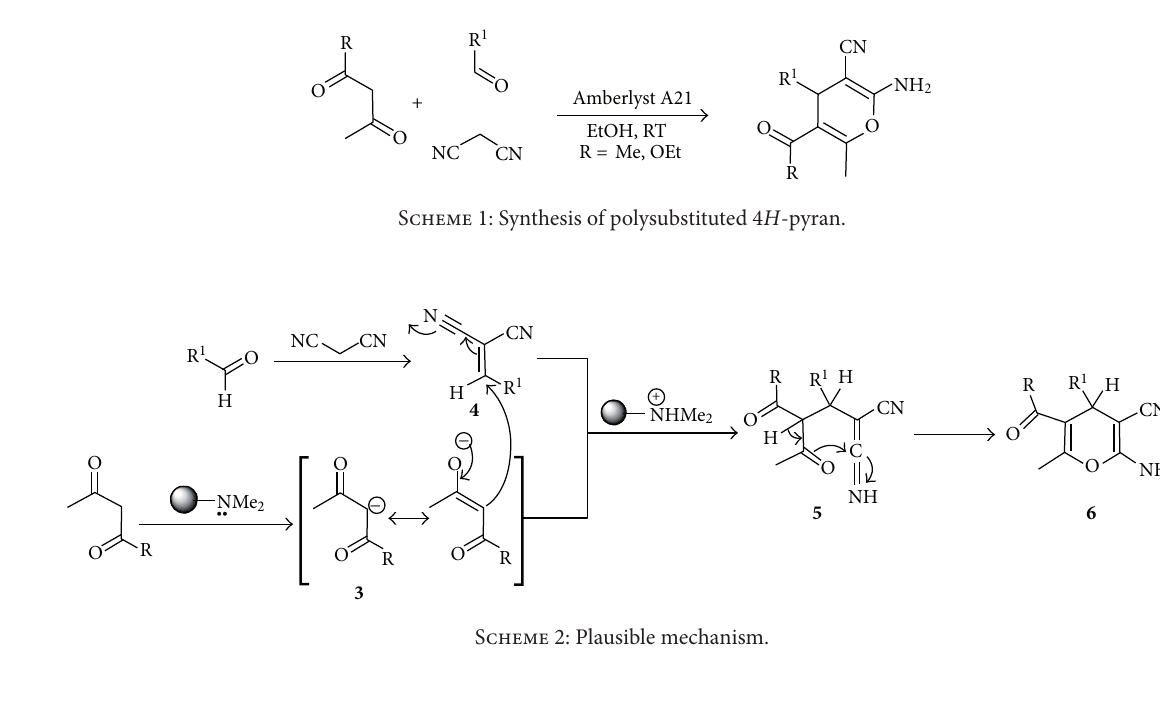
T 1: Screening of solvents. a